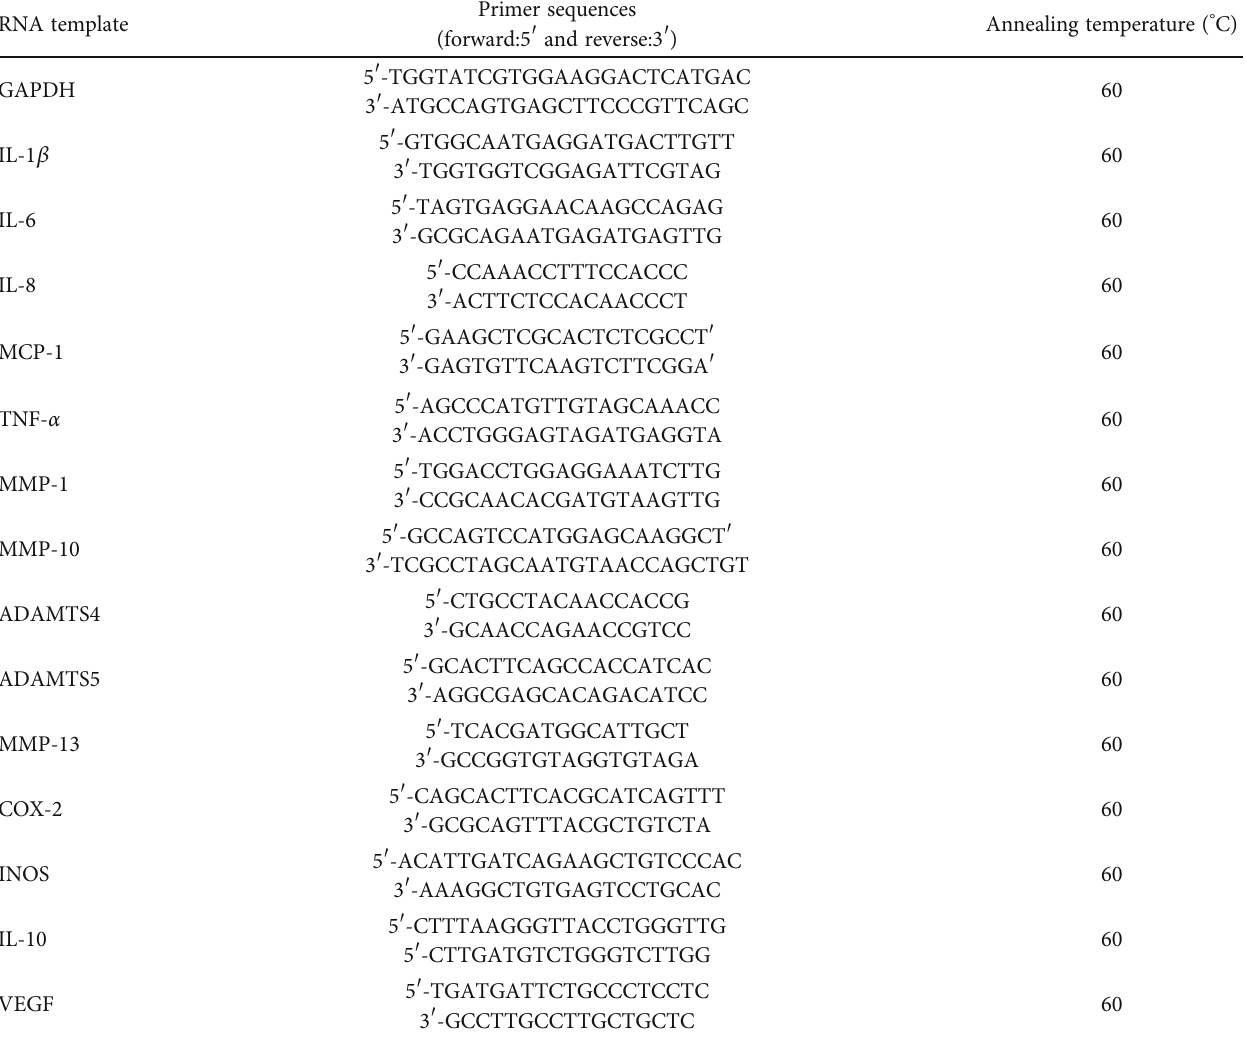
Table 1: List of primers used in real-time